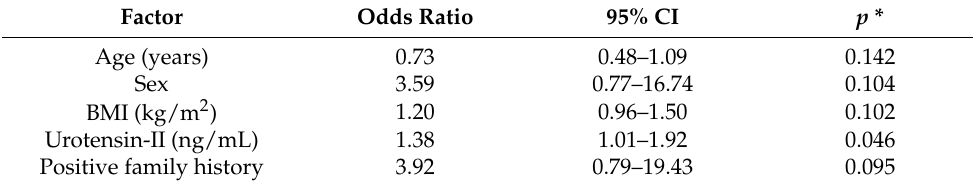
Table 3. Multivariable logistic regression model of prediction for metabolic syndrome.